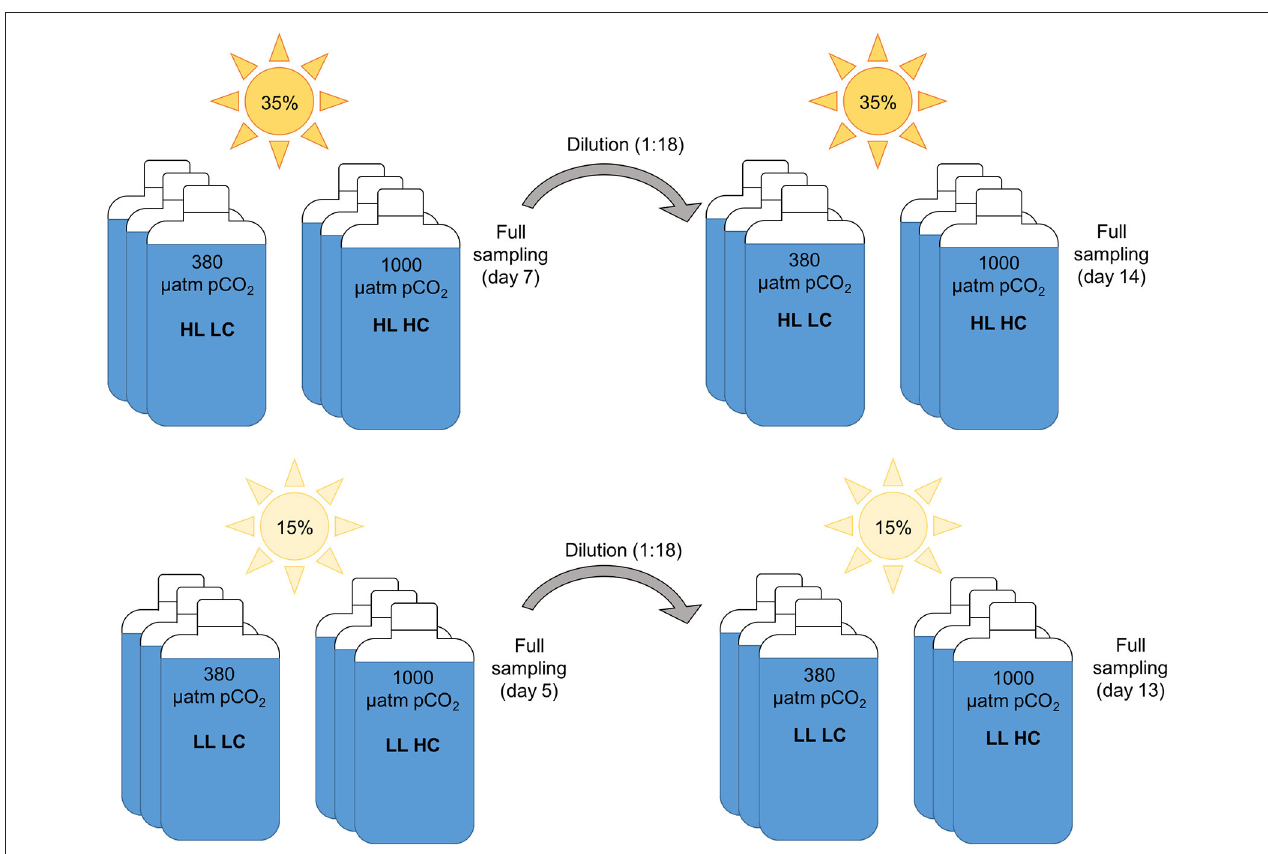
FIGURE 1 | Schematic of experimental setup and sampling time